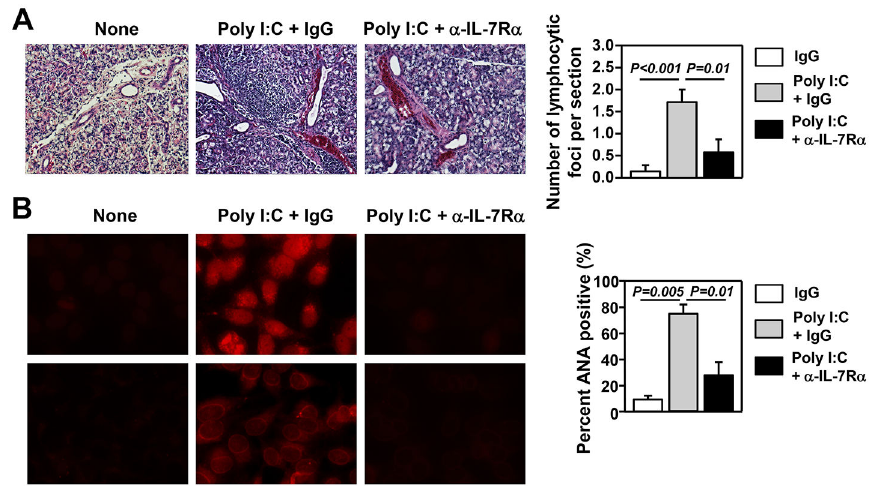
Figure 4. Poly I:C accelerates the development of SS in an IL-7-dependent manner. Poly I:C, together with either IgG or anti- IL-7Rα antibody, was administered to 12-week old B6.NOD- Aec mice 3 times weekly for 8 weeks. All the following parameters were measured after 8 weeks of consecutive injections. (A) H&E staining of submandibular gland sections (left panels) and focus score of leukocyte infiltration in submandibular glands (right panel). (B) Detection of serum ANA, left panels, and percentages of mice that are serum ANA positive, right panel. All data are representative or the average of analyses of 7 individual mice (1-3 mice per experiment, total 4 independent